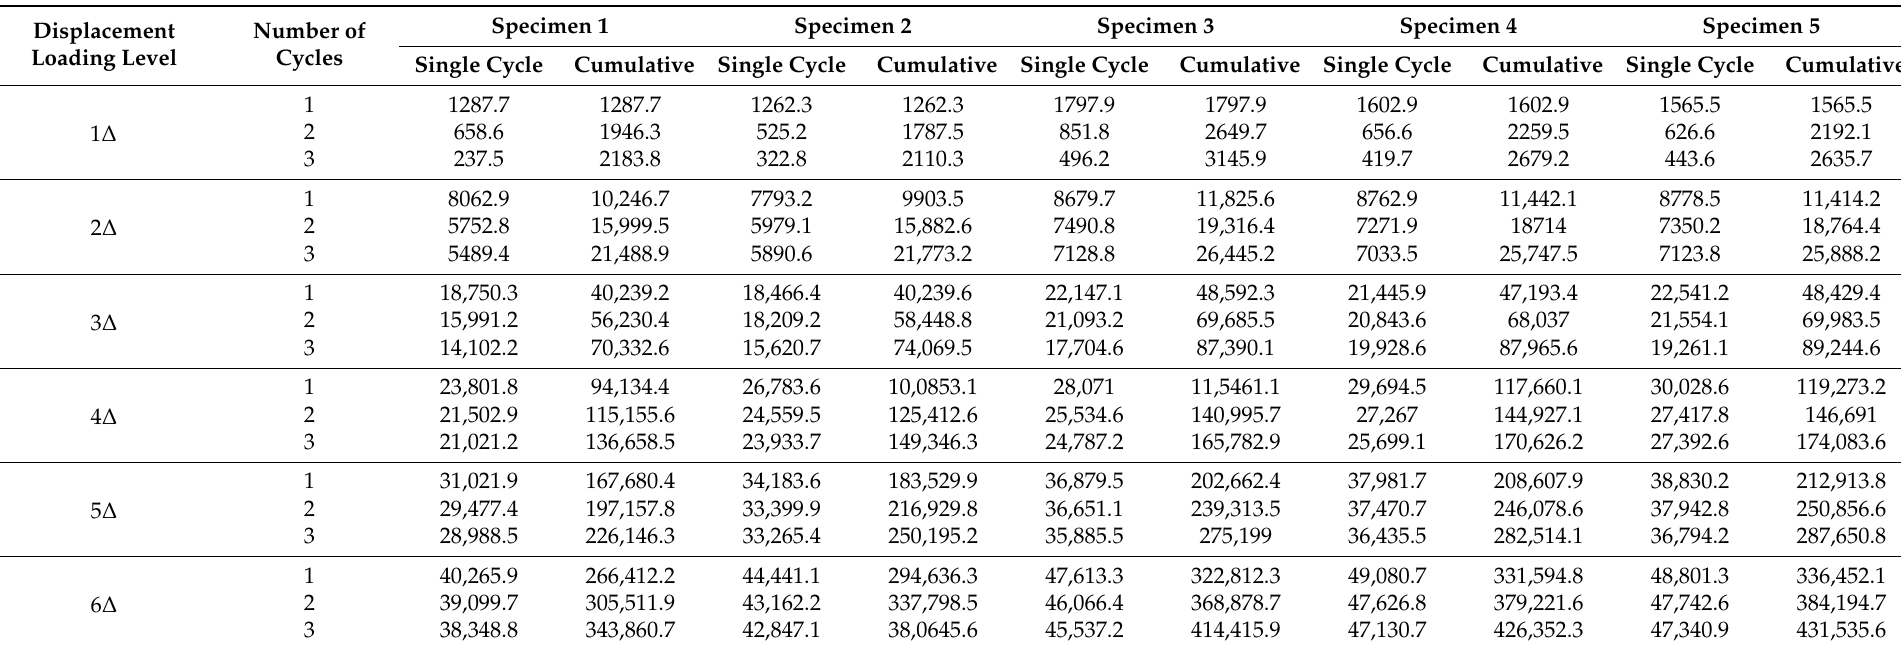
Table 2. Single cycle/cumulative energy dissipation of specimens